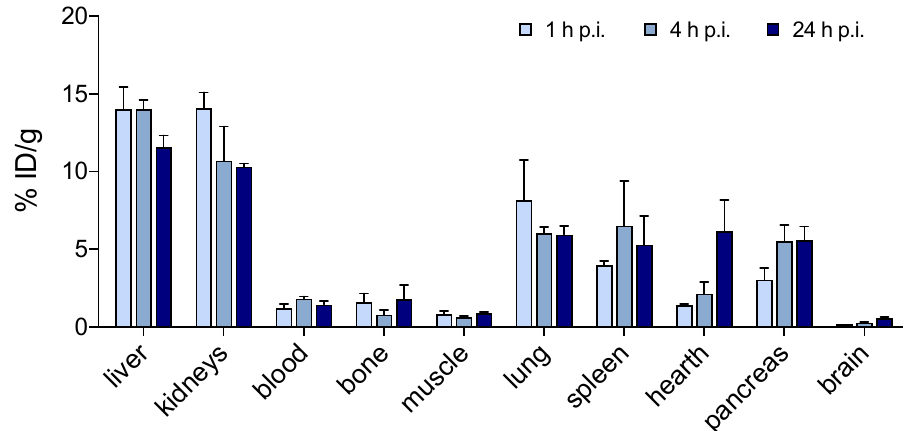
Figure 8. [ 64 Cu][Cu(DO2A2S)] biodistribution in nude BALB/C mice at 1, 4, and 24 h post injection by tail vein. Data are presented as mean ± SEM ( n = 3/group).